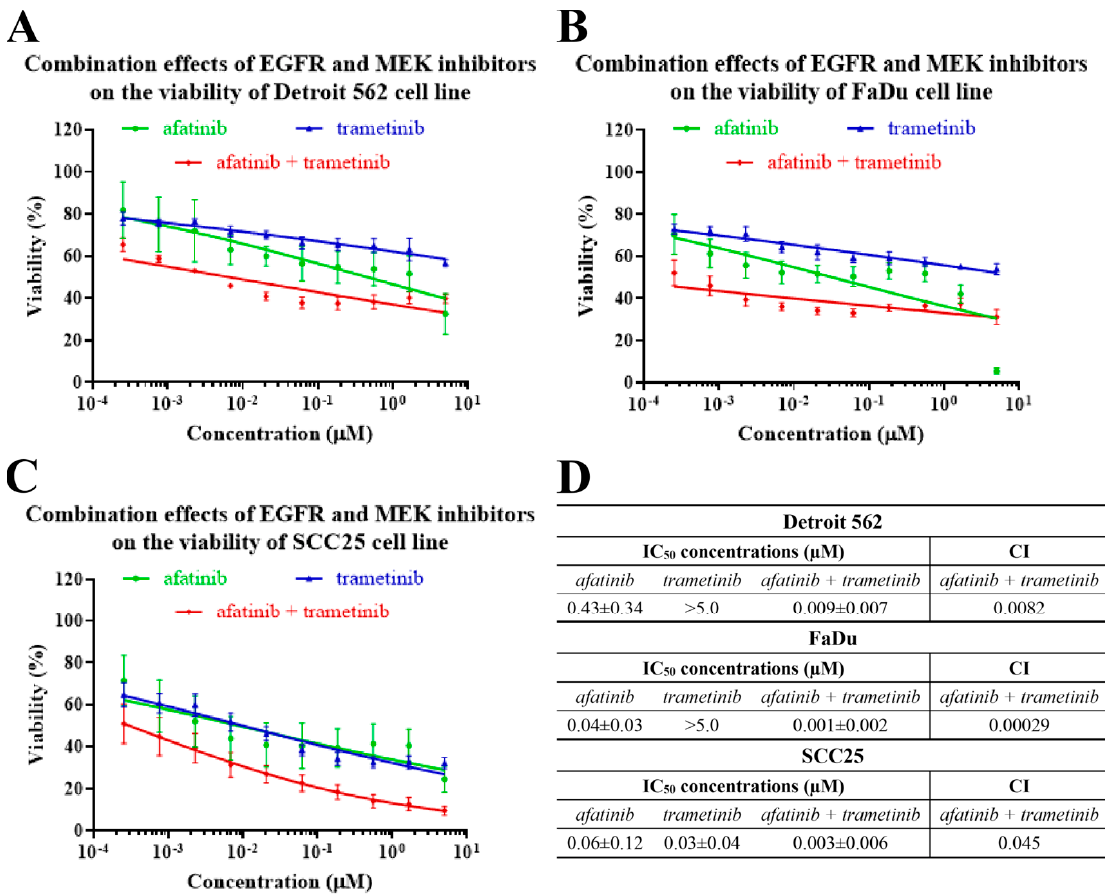
Figure 5. The effects of EGFR-inhibitor (afatinib) and MEK-inhibitor (trametinib) combinations on cell viability. The HNSCC cell lines were analyzed in parallel by MTT after 72 h of treatment with afatinib + trametinib (1:1) at different concentrations. The IC 50 curves of the effects of the inhibitors on Detroit 562 ( A ), FaDu ( B ) and SCC25 ( C ) cell lines. ( D ) The IC 50 values and combination indexes (CIs) of the effects of the different drug combinations on Detroit 562, FaDu and SCC25 cells. All data are represented as the mean ± SD of five independent measurements. The CIs were generated by CompuSyn, CI < 0.75 indicates synergism; CI between 0.75 and 1.25 indicates additive effects, and CI > 1.25 indicates